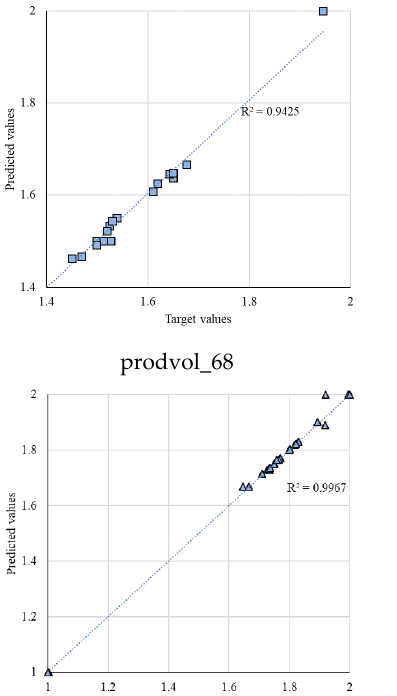
Figure 8. Plot diagrams for the effects of employee voice on output values of employee wellbeing.